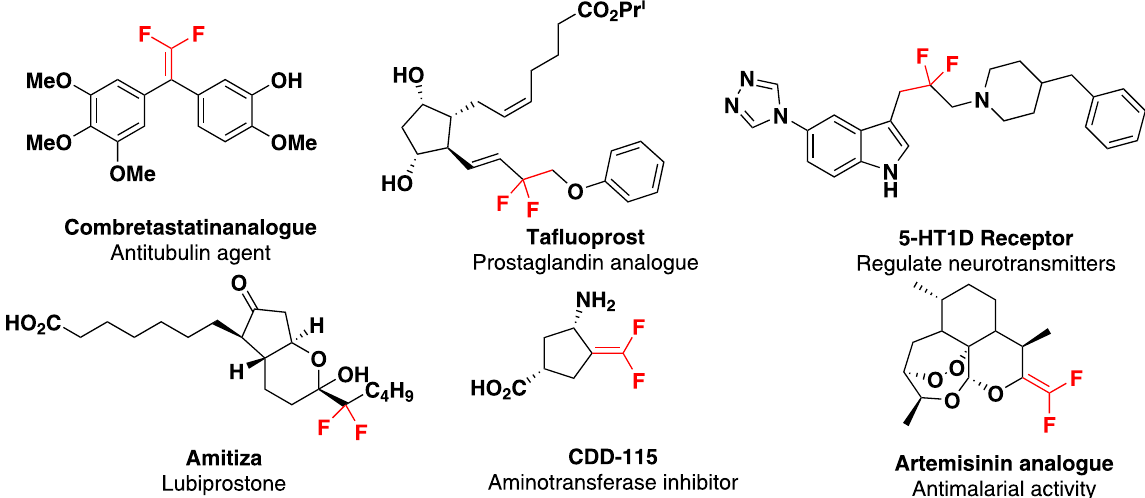
Fig. 1 Presence of gem-di fl uoroethylene moiety. gem-Di fl uoroethylene moieties present in natural products and potential therapeutic